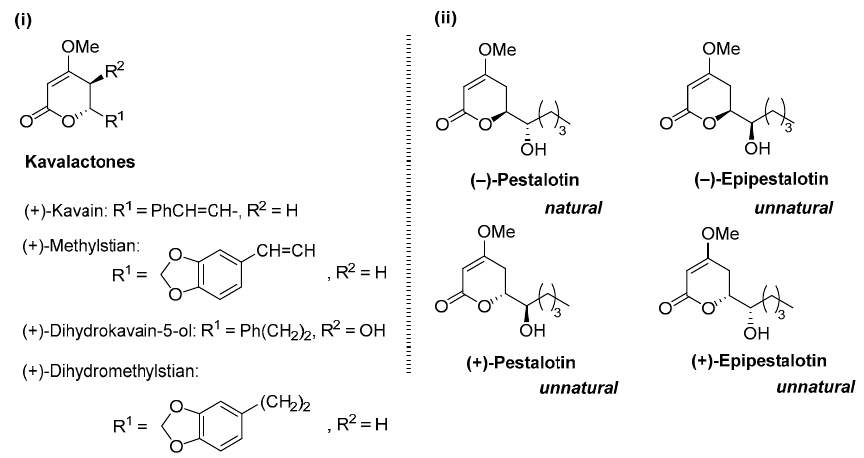
Figure 1. Natural and the related unnatural products of 4-methoxy-5,6-dihydroxy-pyran-2-one.